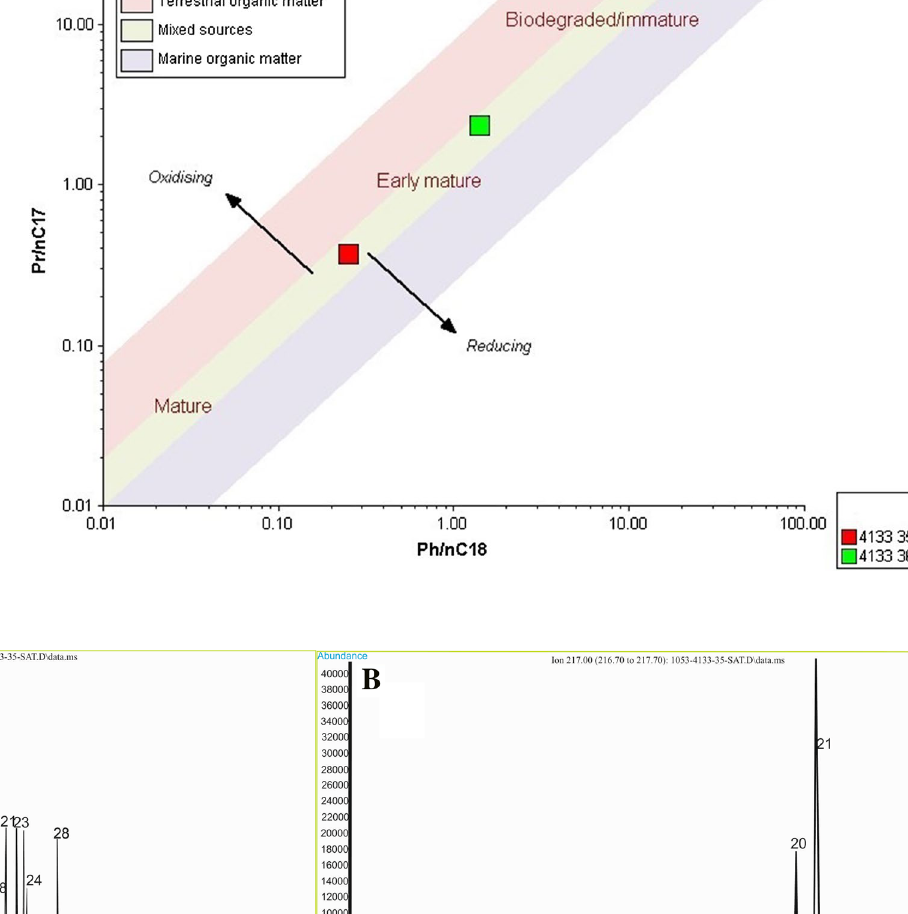
Fig. 9 Pristane/nC17 versus Phytane/nC18 diagram. (4133 35: Turabi Fm., 4133 36: Halıkışlak Fm.)